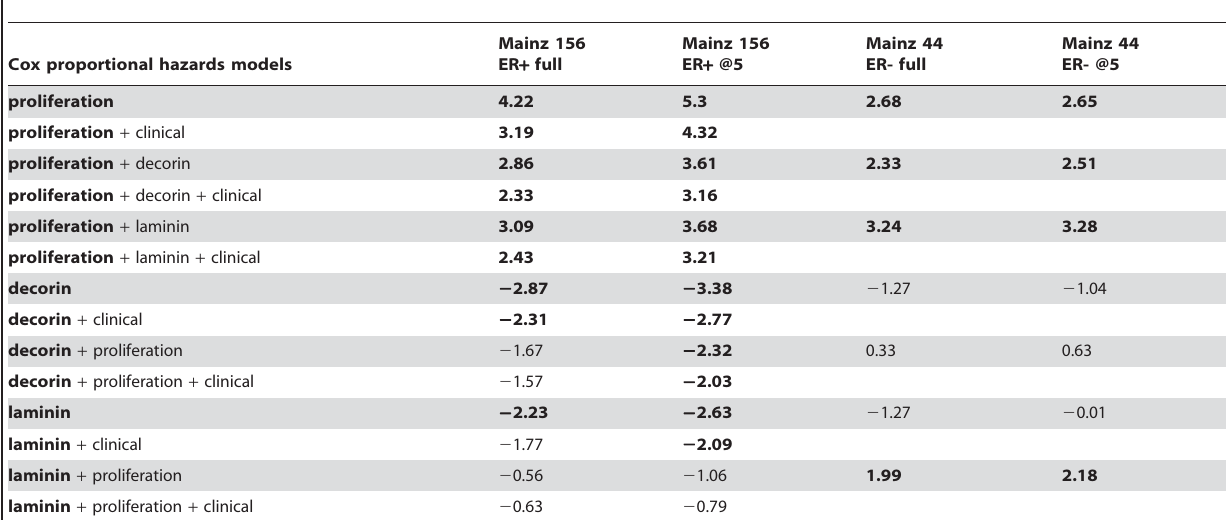
Table 7. Cox proportional hazards models for the MAINZ